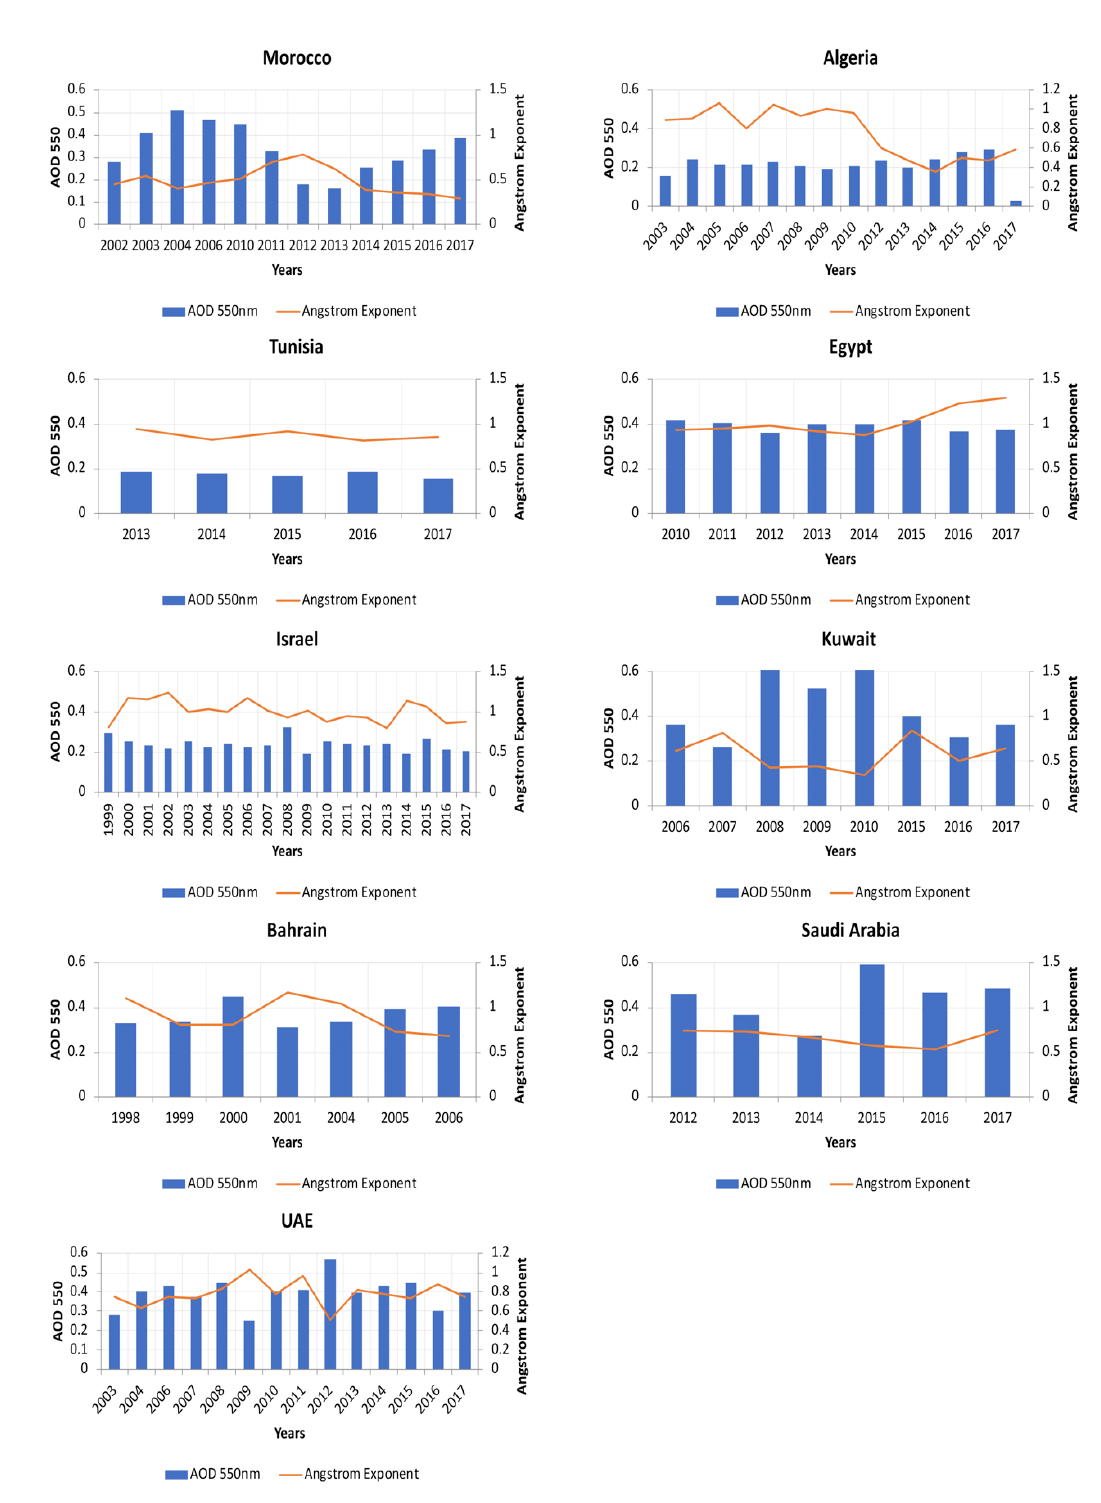
Figure 8. The relationship between the aerosol optical depth and Ångström exponent in the MENA region.